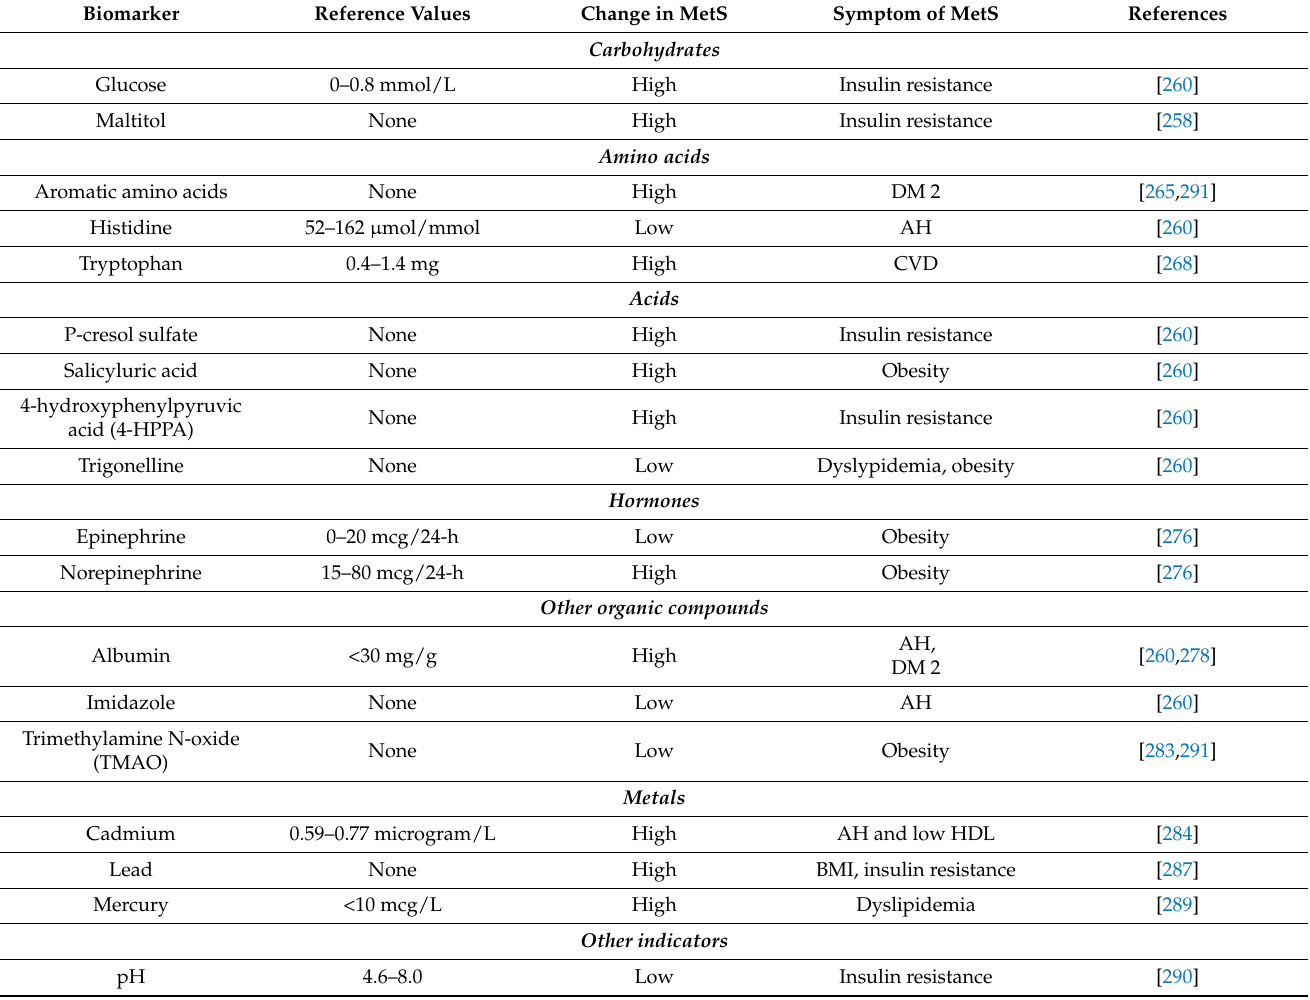
Table 2. Potential Urinary Biomarkers of Antipsychotic-Induced Metabolic